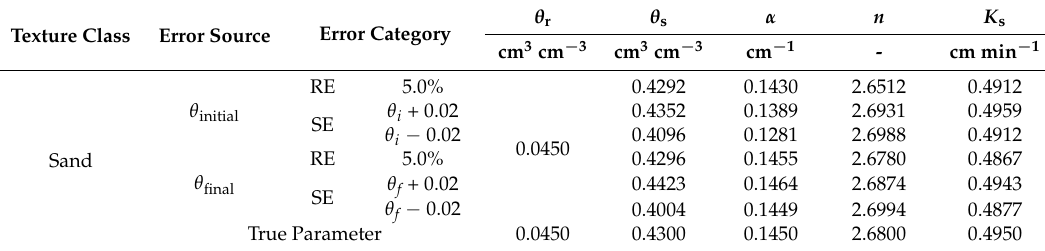
Table 5. Estimated parameters considering random and system errors on initial and final water content levels for the four typical